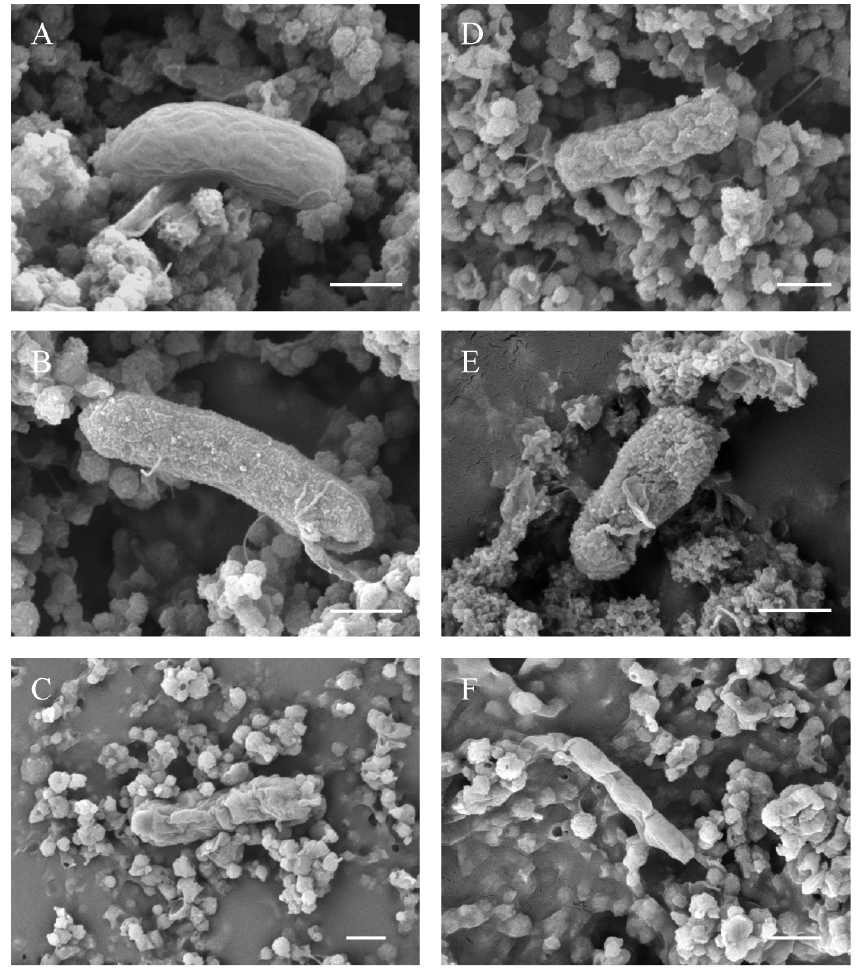
Figure 3. Scanning electron micrographs of E. coli resulting from different treatments: ( A ) control group (×40,000); ( B ) freezing (×40,000); ( C ) HP 400 MPa (×22,000); ( D ) LTHP 200 MPa (×30,000); ( E ) LTHP 400 MPa (×40,000); ( F ) LTHP two-cycle 400 MPa (×30,000). The scale bars represent 0.5 µm.